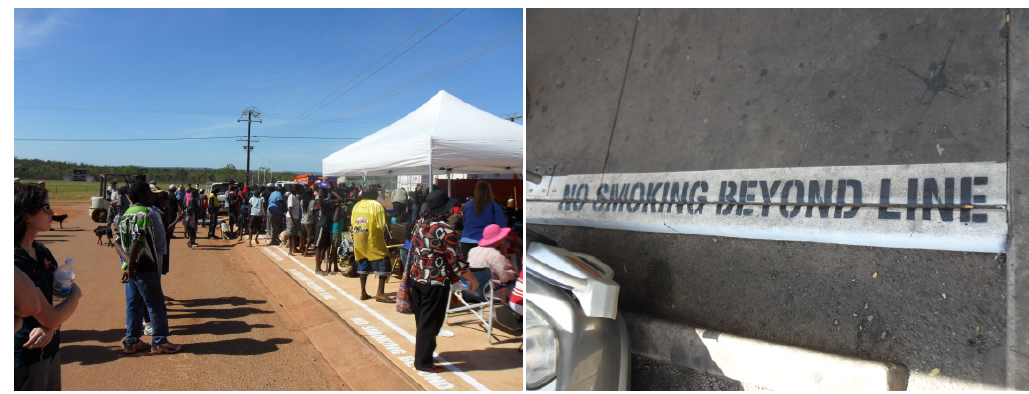
Figure 5. Opening of new smoke-free store